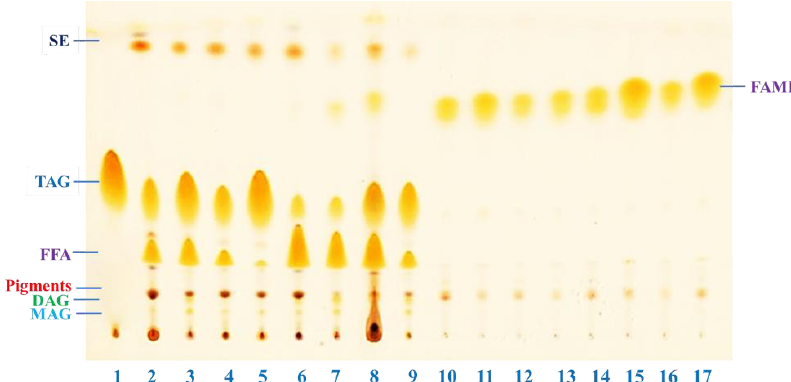
Figure 5. Separation of total lipid extracted from R. toruloides grown on 40 g/L glucose with C/N 20 (lane 2) and 500 (lane 3), 20 g/L xylose with C/N 20 (lane 4) and 500 (lane 5), mixture of glucose (40 g/L) and xylose (20 g/L) with C/N 20 (lane 6) and C/N 500 (lane 7), and BSG hydrolysate with C/N 20 (lane 8) and C/N 500 (lane 9). Glyceryl trioleate was used as standard for TAG (triacylglycerides) (lane 1). Corresponding fatty acid methyl esters after transesterification are spotted in lane 10 to lane 17.